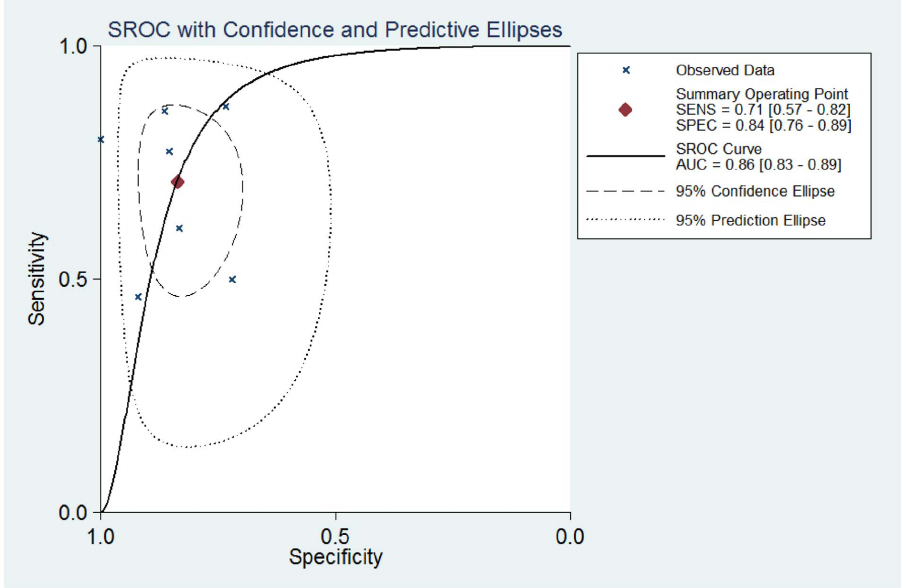
Figure 3. Summary ROC curve of miR-21 diagnostic value in lung carcinoma.